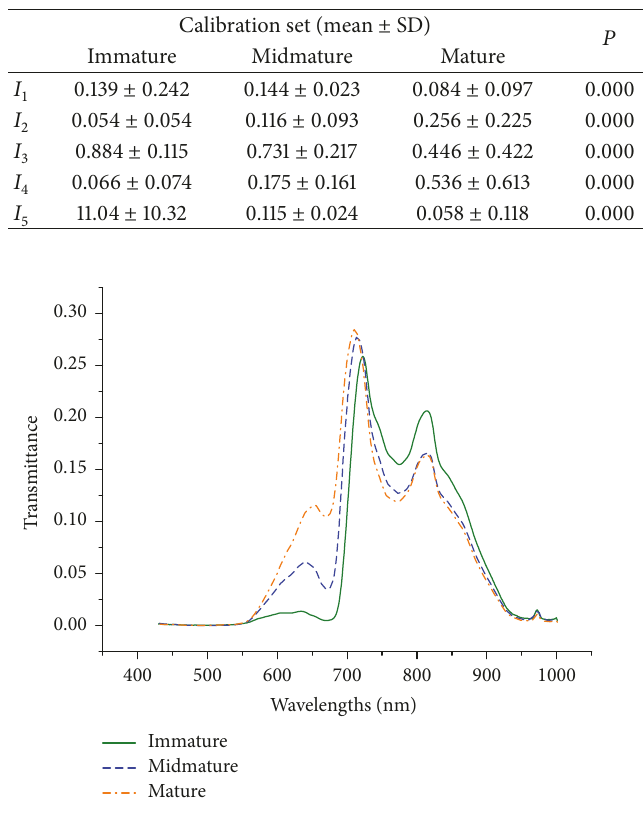
Figure 2: Average spectra of navel oranges at three different matur- ity